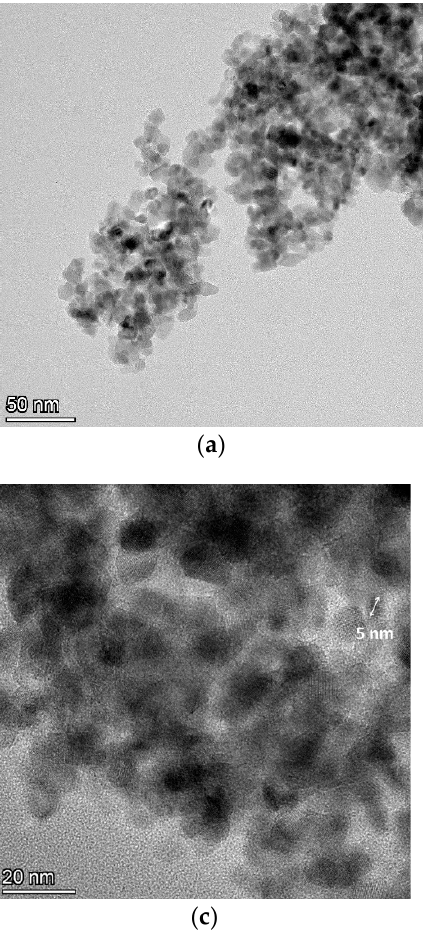
Figure 8. Degradation curves of Rhodamine B for different amounts of catalyst and irradiation time, under visible light irradiation. Photolysis of the pollutant is also included. It is observed that Rhodamine B is a pollutant with high resistance to the catalyst, as its final degradation value reaches only 50% for 200 min irradiation. Even at 10 g/L, a catalyst load that is considered high, the degradation curve is similar to the one for the 1